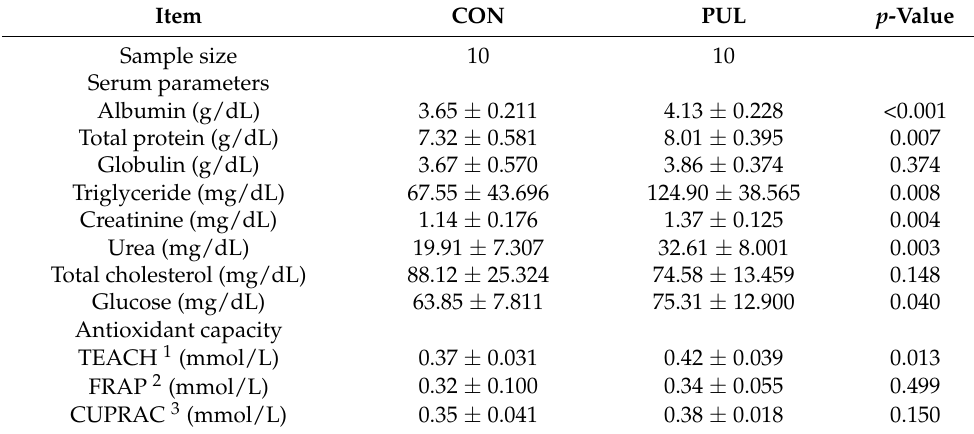
Table 4. Serum parameters and antioxidant capacity of Iberian sows fed control and olive-pulp- supplemented diet during gestation period (mean ±